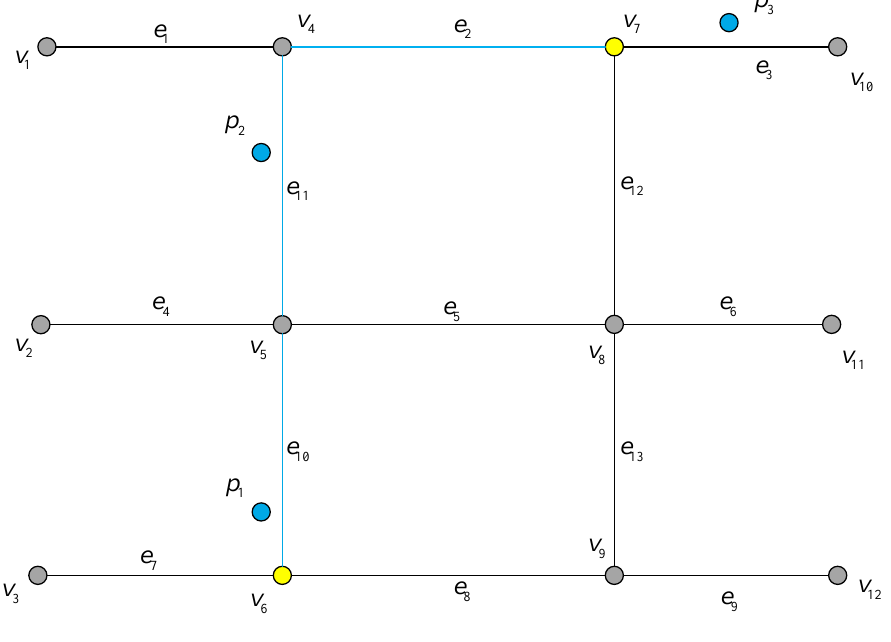
Figure 7. Finding matching paths.